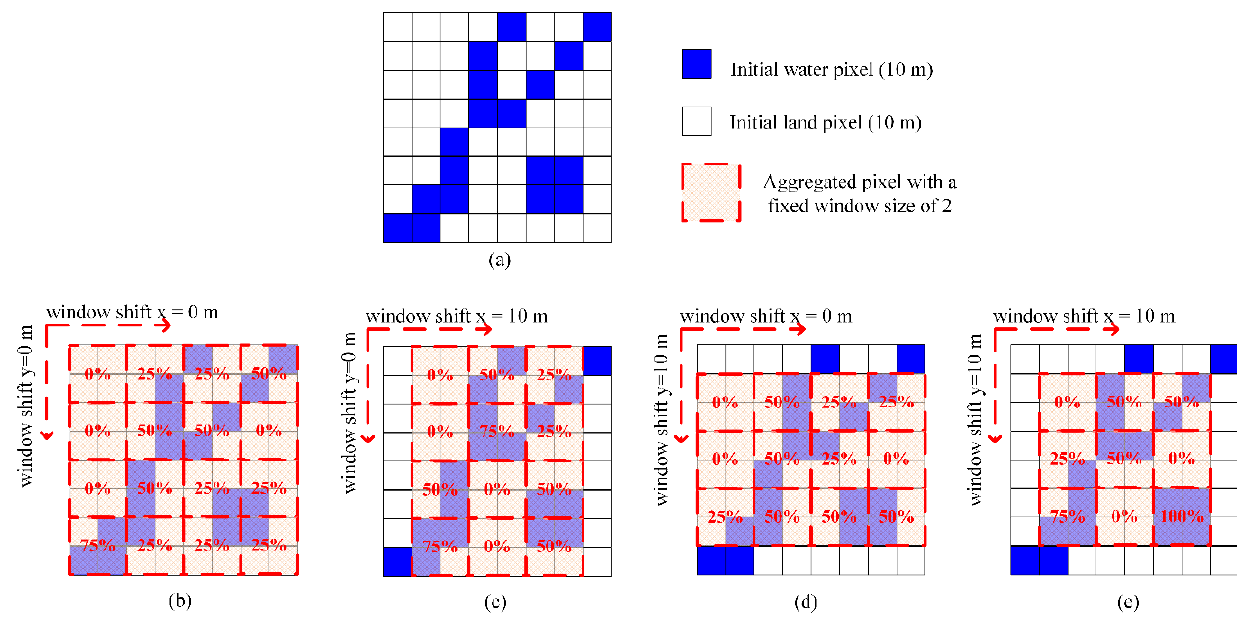
Figure 5. Flowchart of producing aggregated surface water fractions from the initial surface water map from OTSU segmentation with different window shifts (using window size = 2 as an example). ( a ) Initial binary surface water map and ( b – e ) generating aggregated surface water fractions from the initial surface water map with multiple (i.e., all possible) window shifts in the x- and y-directions. forest (RF) model,